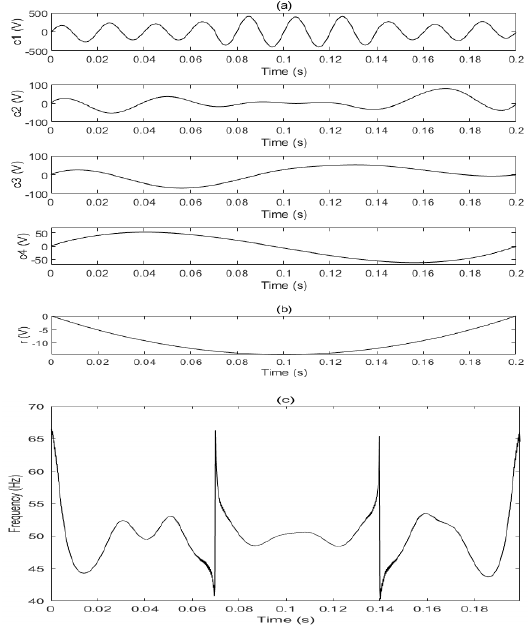
Figure 3. Voltage swell IMF components ( a ), margin ( b ), and frequency parameter ( c ).